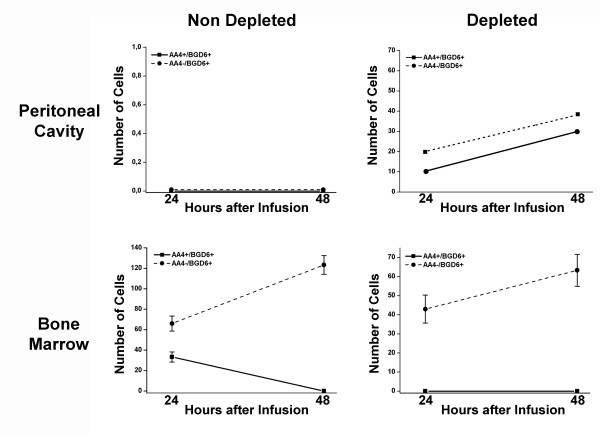
When the peritoneal cavity is depleted of mast cells, both AA4-/BGD6+ and AA4+/BGD6+ cells go to the peritoneal cavity, but only the MCcp (AA4-/BGD6+) home to the bone marrow . MCcp (AA4-/BGD6+) and MCp (AA4+/BGD6+) were immunomagnetically isolated from the bone marrow and labelled with CellTracker Green CMFDA™ or CellTracker Red CMTPX™ respectively. The cells were infused into non-depleted and depleted rats. At 24 and 48 hours after infusion, the peritoneal lavage and bone marrow were collected and examined by FACS for the presence of labelled mast cells. The data is expressed as the number of labelled mast cells/105 cells. The average of 3 independent experiments ± SD is shown.